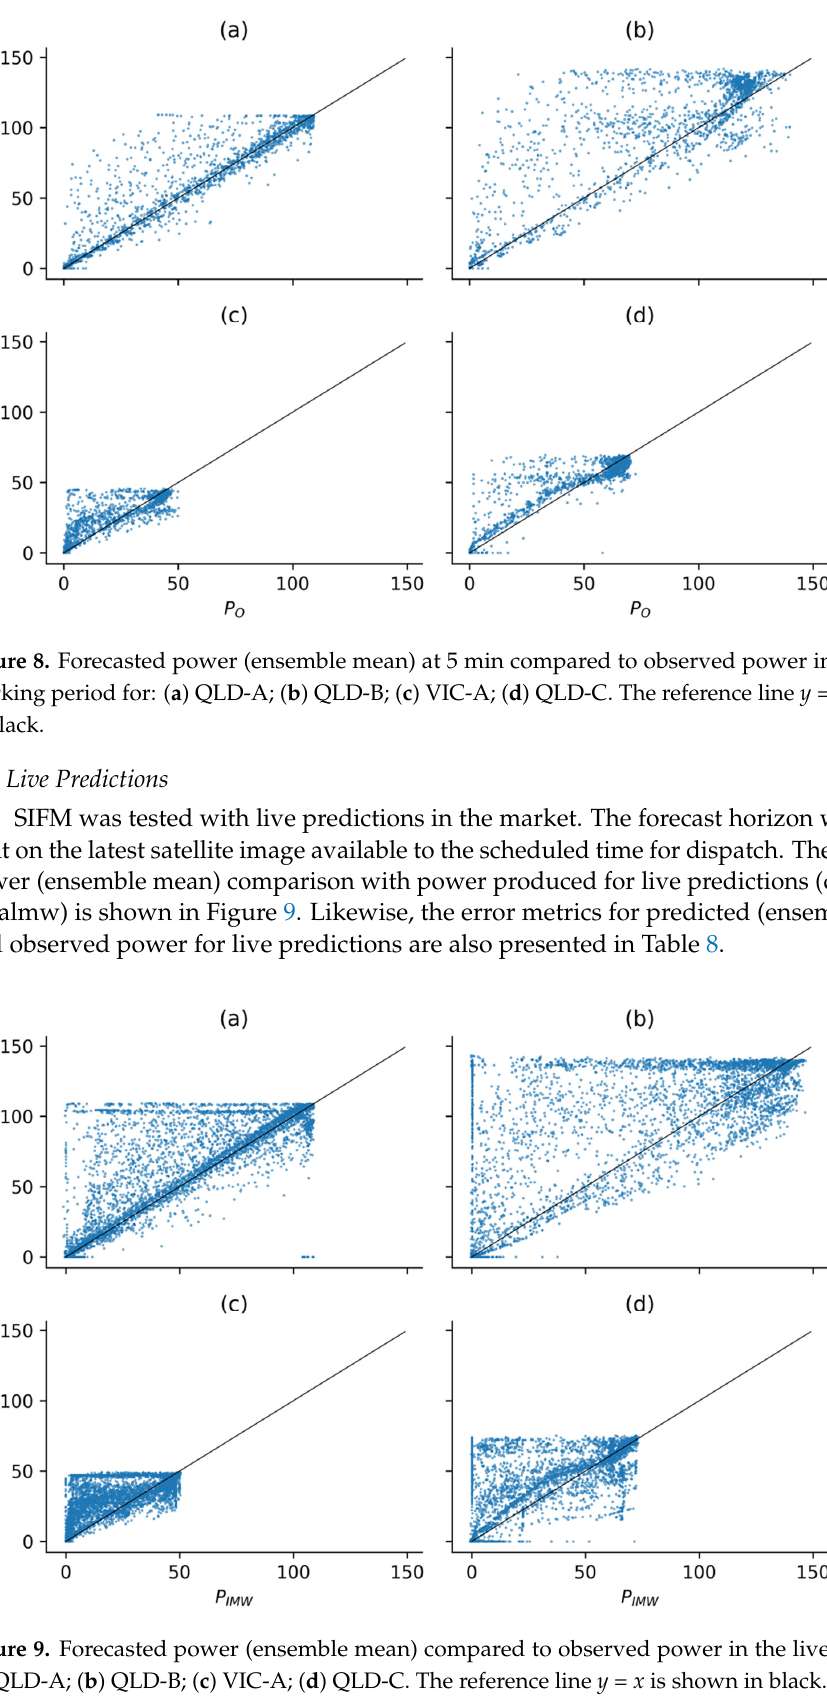
Figure 9. Forecasted power (ensemble mean) compared to observed power in the live period for: ( a ) QLD-A; ( b ) QLD-B; ( c ) VIC-A; ( d ) QLD-C. The reference line y = x is shown in black. Table 8. Error metrics for predicted mean power ensemble for the live